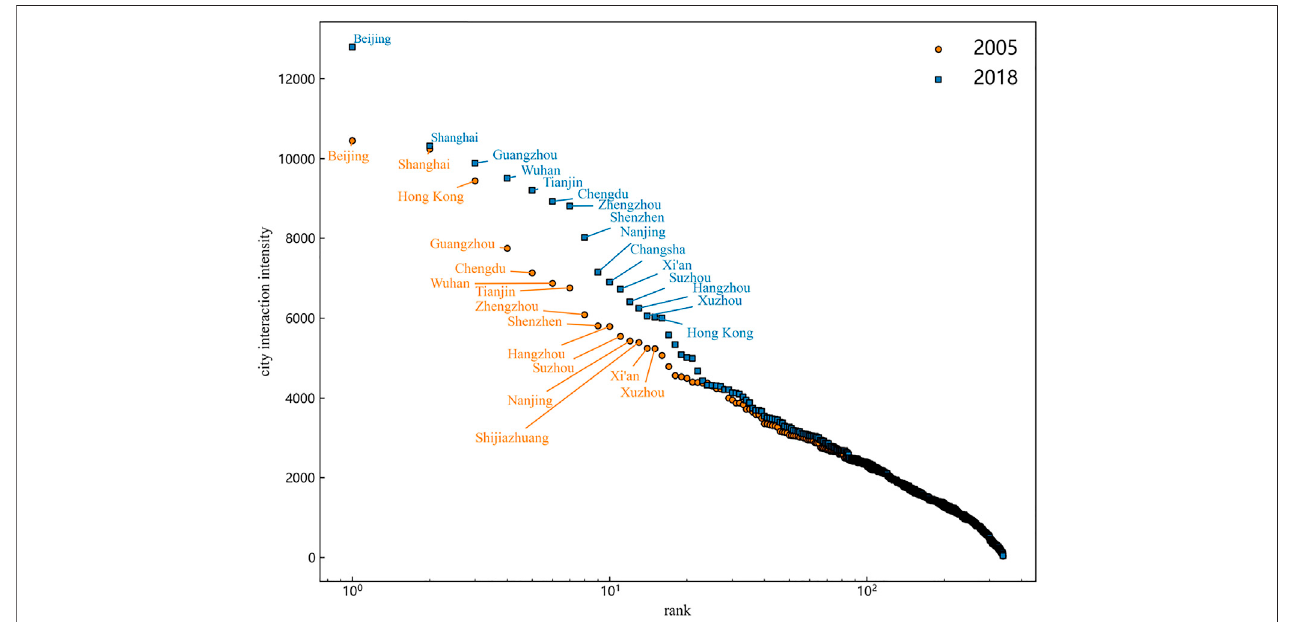
FIGURE 6 | Ranking of city interaction intensity. The circular dot and square dot in the fi gure represent the city interaction intensity in 2005 and 2018, respectively. The horizontal axis represents the ranking of cities, and the vertical axis represents the city interaction intensity.